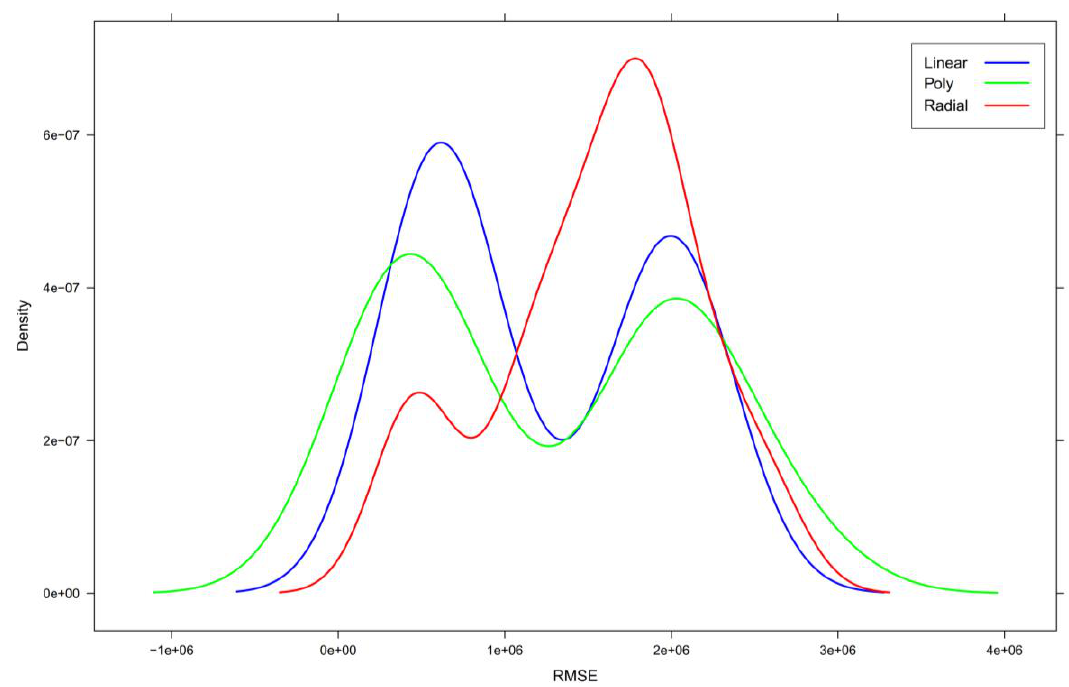
Figure 7. RMSE vs. Density based on Kernel Comparisons Table 2. Sum Insured